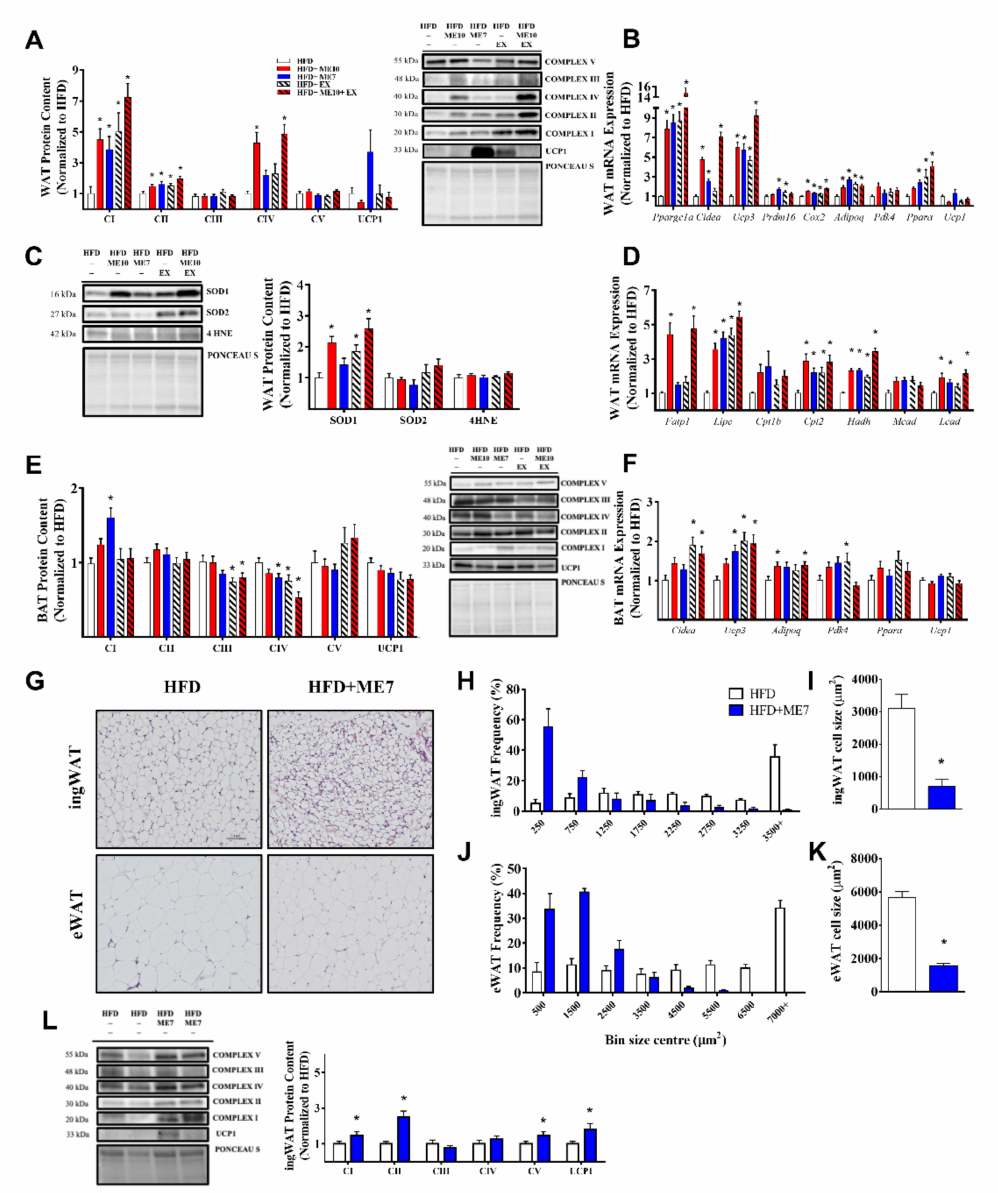
Figure 2. Metabolic enhancer (ME) supplementation and/or exercise induces greater OXPHOS protein expression, mRNA expression of markers of the browning program, and mitochondrial biogenesis during HFD in epididymal white adipose tissue (eWAT). Protein expression ( A ) of OXPHOS complexes (complex I–V) and uncoupling protein 1 (UCP1) in WAT tissue, expressed relative to the HFD group with representative blots. mRNA expression ( B ) of browning-related genes in WAT. Protein expression ( C ) of antioxidant SOD1 and SOD2, and marker of lipid peroxidation 4-Hydroxynonenal (4-HNE) with representative blots. Gene expression ( D ) indicators of lipid transportation and β -oxidation in WAT. Protein expression ( E ) of OXPHOS complexes (complex I–V) and uncoupling protein 1 (UCP1) in in brown adipose tissue (BAT). mRNA expression ( F ) of browning-related genes in BAT. 1-way ANOVA with Fisher’s LSD post-hoc test. *: p < 0.05 compared to high-fat diet (HFD) group. Data are represented as the mean ± SEM ( n = 10–12 per group). To confirm observations in eWAT, we performed an experiment in an additional subset of animals, examining inguinal white adipose tissue (ingWAT). ( G ) Representative haematoxylin and eosin stain of ingWAT and eWAT depots (magnification X 10) in HFD and HFD + ME7 groups. ( H ) Frequency distribution of ingWAT cell size and ( I ) mean cell size of ingWAT. ( J ) Frequency distribution of eWAT cell size and ( K ) mean cell size of eWAT. Protein content ( L ) of OXPHOS complexes and UCP1 in ingWAT tissue, expressed relative to the HFD group with representative blots. Student’s t test, *: p < 0.05 compared to the high-fat diet (HFD) group. Data are represented as mean ± SEM ( n = 6 per